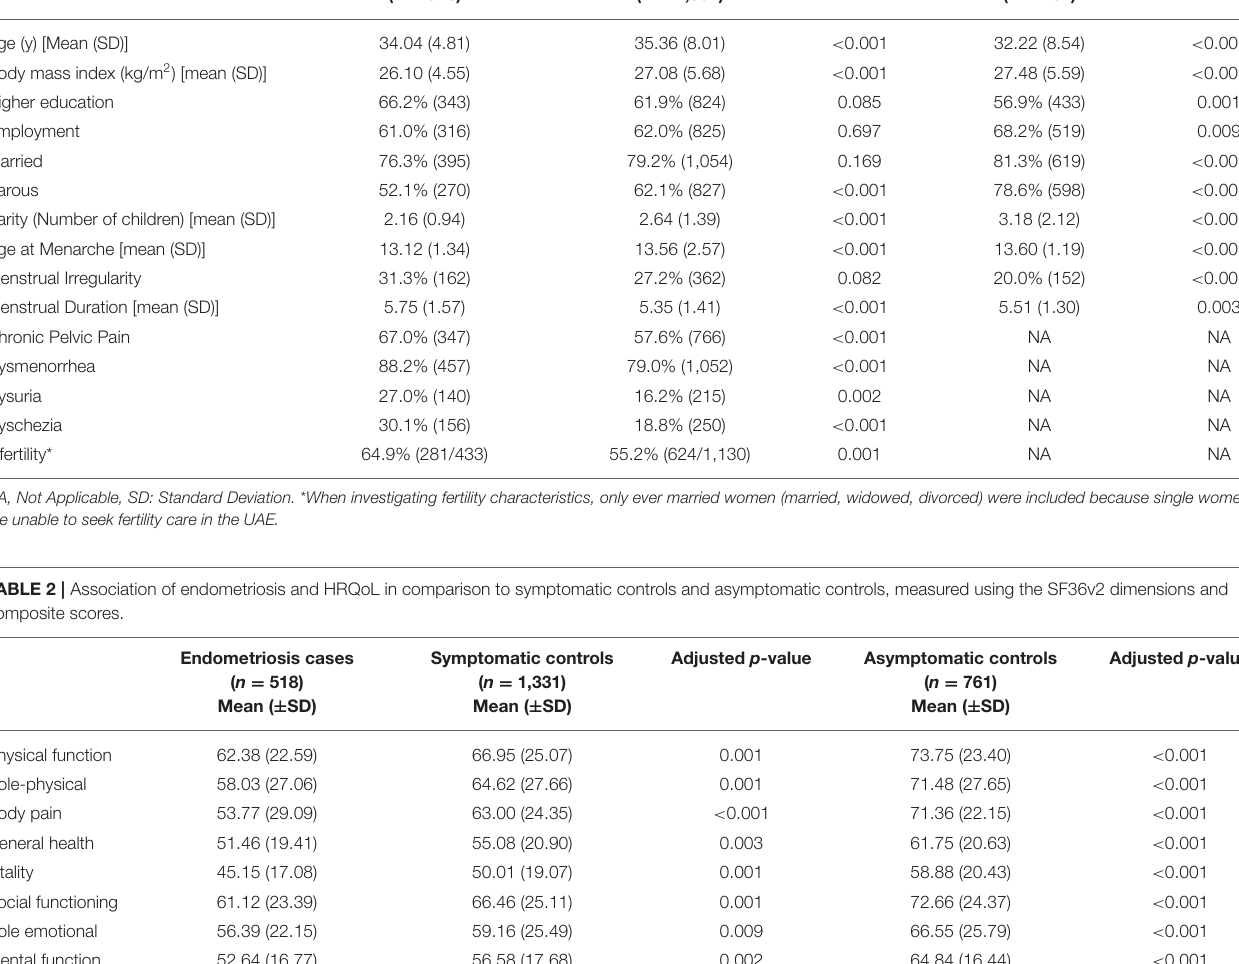
TABLE 1 | Demographic details of the participants based on endometriosis cases vs. symptomatic controls and asymptomatic controls. Endometriosis cases ( n = 518)